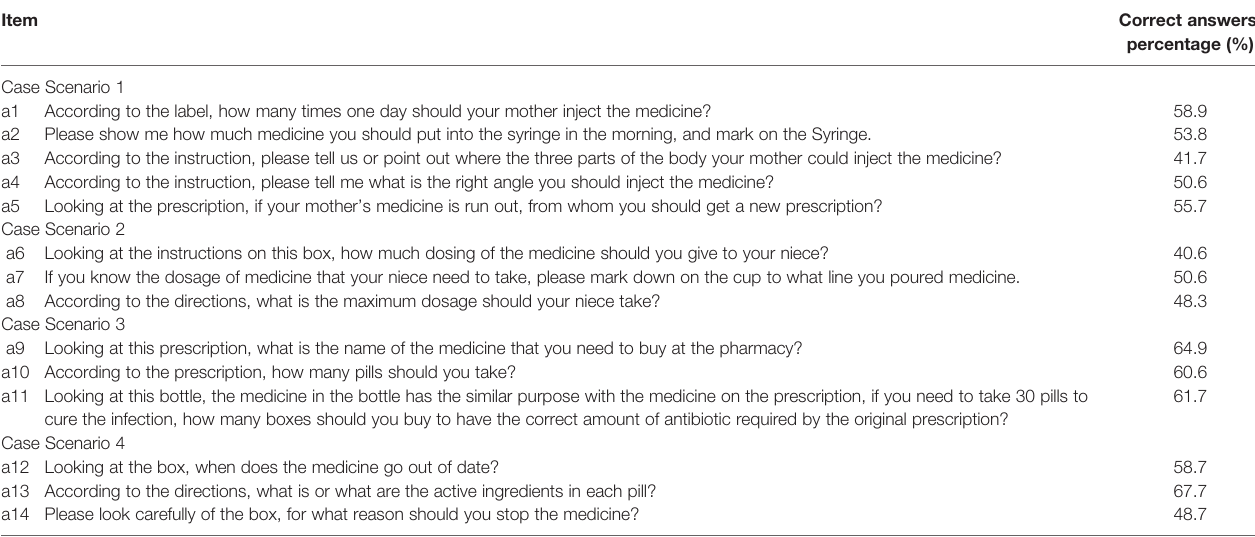
TABLE 2 | Medication Literacy for Inpatients With Coronary Heart Disease, Changsha, Hunan, China (N = 470). Item Correct answers,